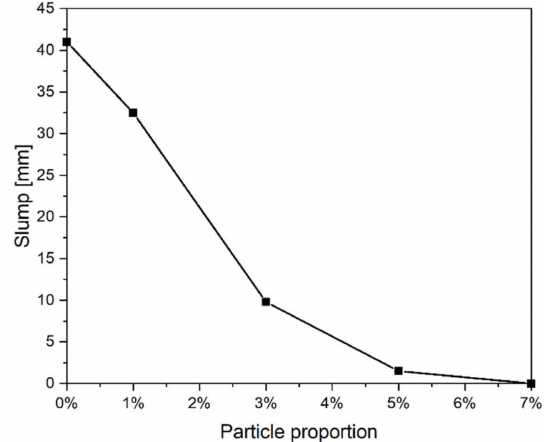
Figure 8. Slump evolution of alkali-treated BSC.